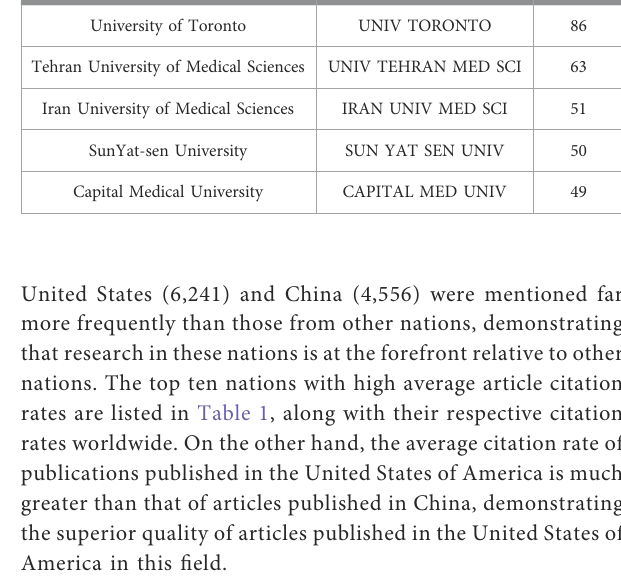
TABLE 1 Average article citations for major participating countries. Country